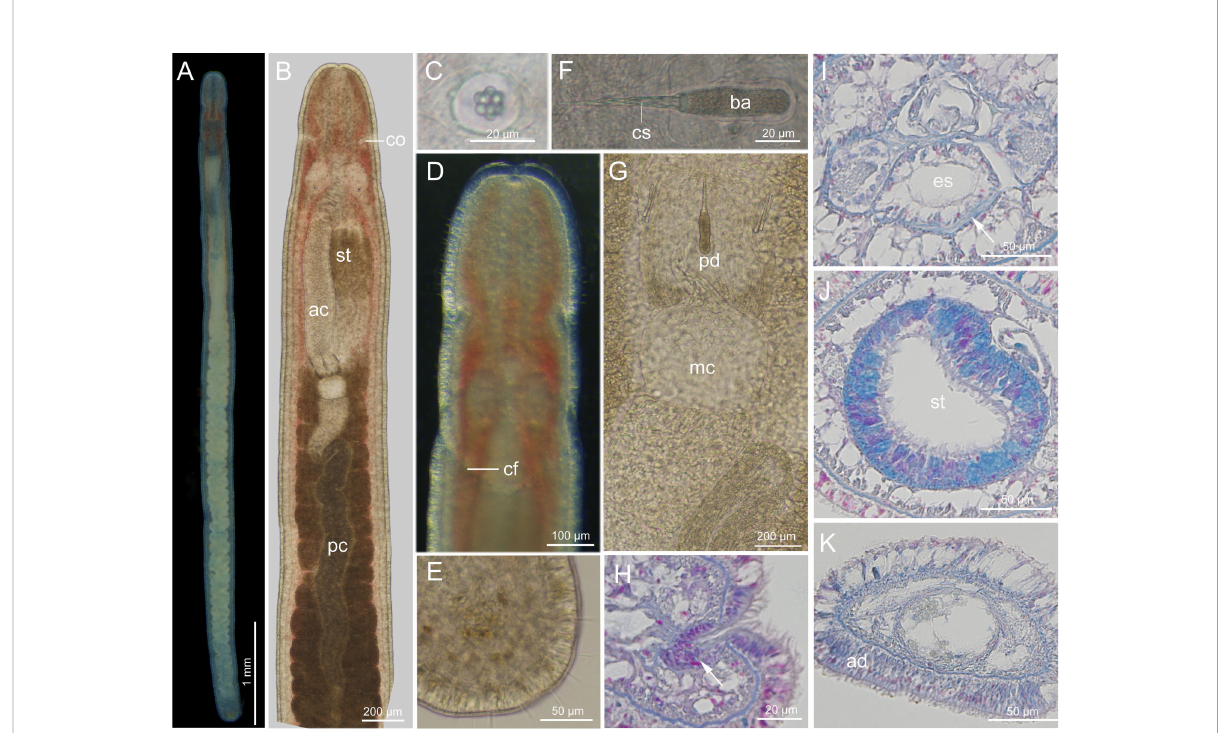
FIGURE 9 Ototyphlonemertes ( Procso ) yingge sp. nov. (A) Photograph of a live specimen; (B) composite photomicrograph of a squeezed specimen; (C) statolith; (D) dorsal view of head; (E) posterior end of body; (F) central stylet and basis; (G) part of proboscis; (H) transverse section through a cerebral organ (arrowed); (I) transverse section through the posterior part of cerebral region, showing the extra ventral commissure (arrowed); (J) transverse section through stomach region; (K) transverse section near caudal end showing the epidermis of caudal adhesion. ac, anterior chamber of proboscis; ad, adhesion plate; ba, basis; cf, cephalic furrow; co, cerebral organ; cs, central stylet; es, esophagus; mc, middle chamber of proboscis; pc, posterior chamber of proboscis; pd, proboscis diaphragm; st,